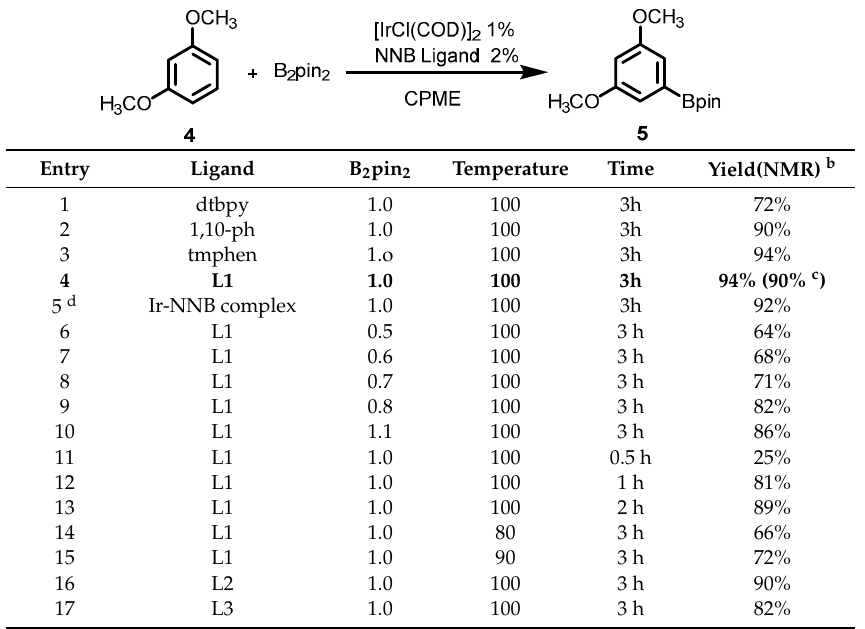
Table 1. Variations from the “standard” reaction conditions of iridium-catalyzed C–H borylation a .